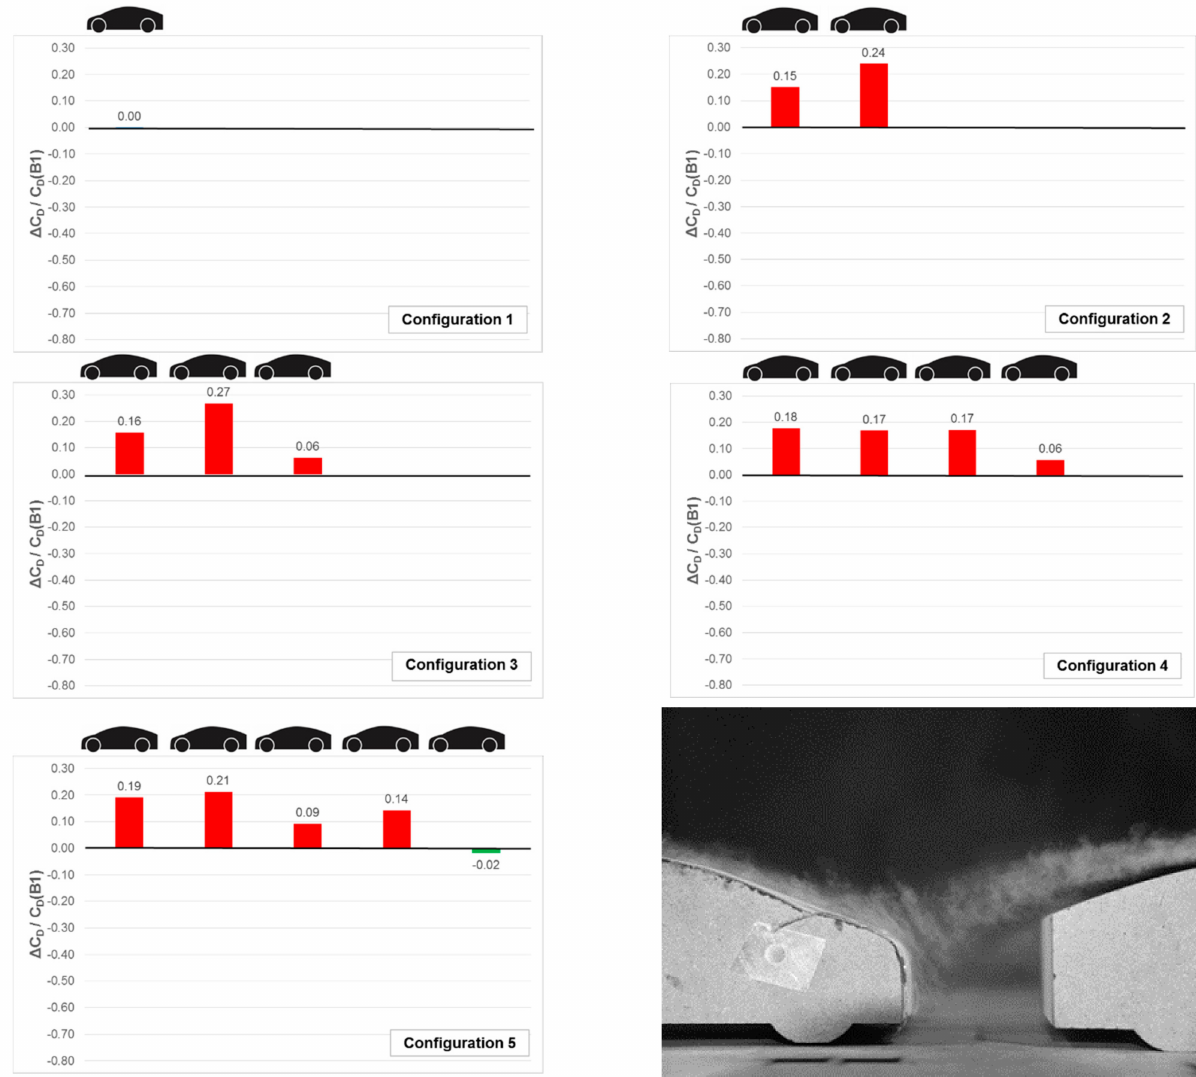
Figure 6. Change in Drag Coefficient ( ∆ C D ) between that of the baseline Resnick model (B1) alone and for individual constituents of 2, 3, 4, and 5-model platoons comprising B1 model configurations after [50] © SAE International 2018. ( Right bottom ) Smoke visualisation of flow regime between two Resnick model baseline (B1) configurations, after [50] © SAE International